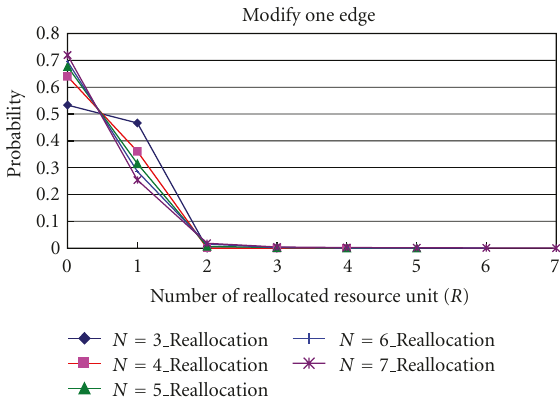
Figure 9: Probability density function of R : one-edge